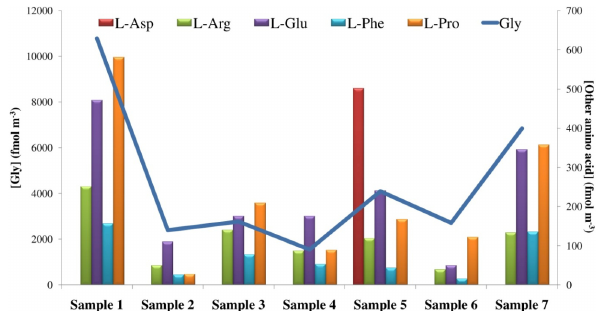
Figure 7. Amino acid distribution in the aerosols sampled on the R/V Italica during the oceanographic cruise on the Southern Ocean during the summer of